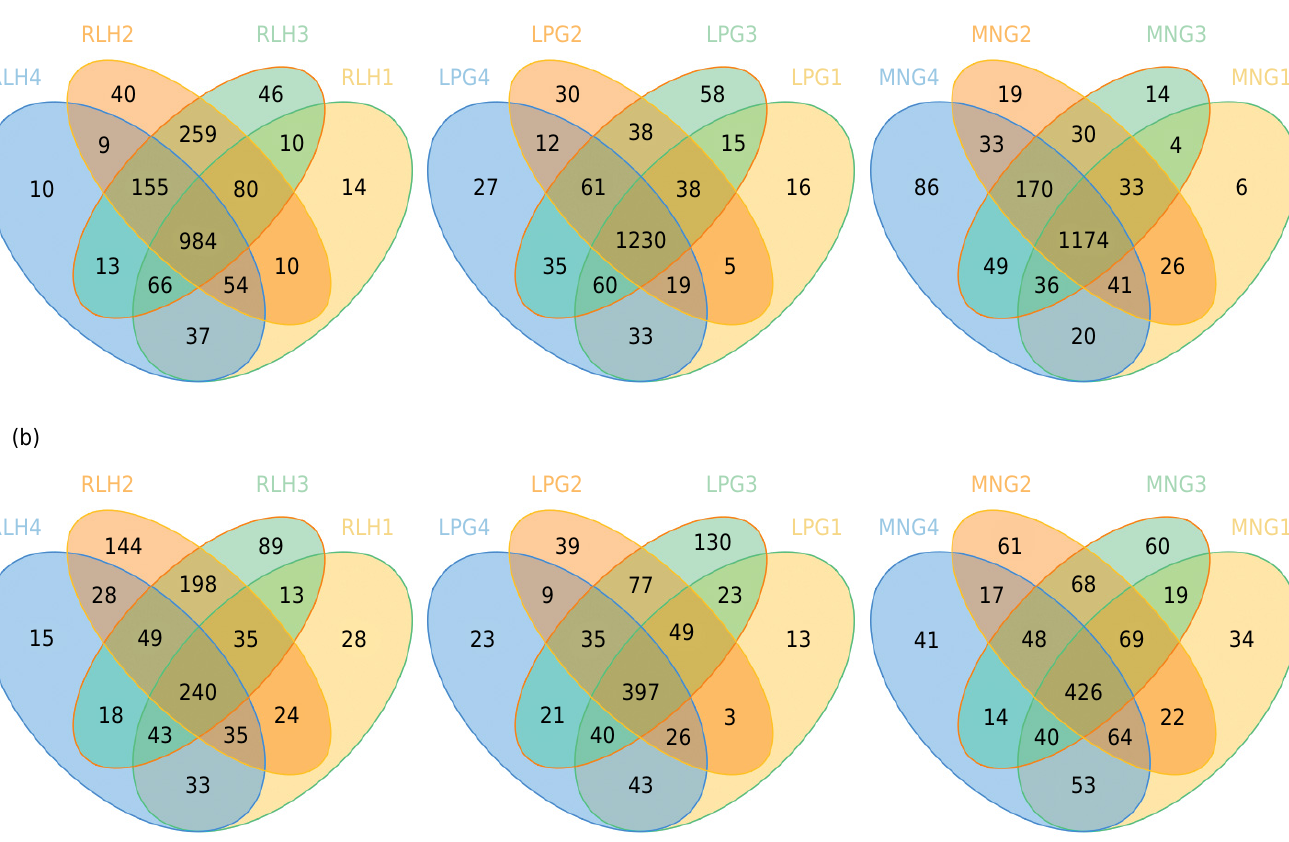
Figure 3. Bacterial (a) and fungal Venn (b) diagrams of OTUs within same methods in different seasons. Note: RLH: raising laying hens under forest; LPG: cultivating Lolium perenne grass under forest; MNG: maintenance of native grass under forest. The number after the treatment symbol means: 1 = spring; 2 = summer; 3 = autumn; 4 =